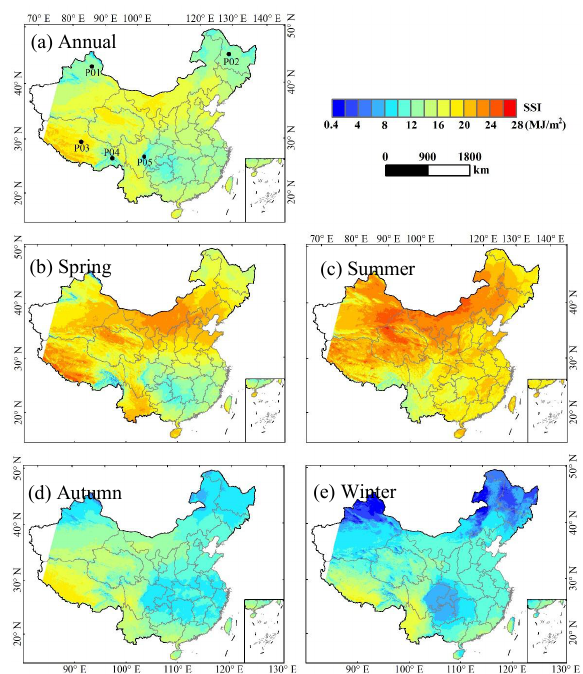
Figure 8 . Spatial distributions of the annual and seasonal average daily global SSI variations in China from March 2016 to February 2017.